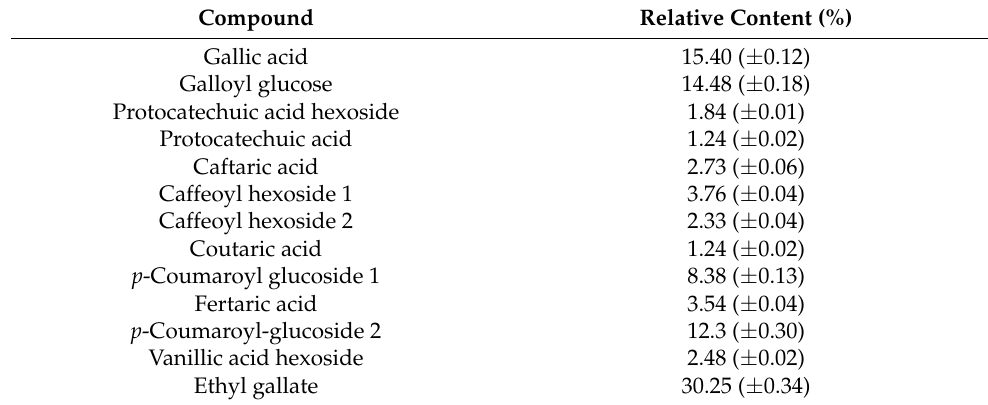
Table 13. Relative content of phenolic acids in the EtOH-H 2 O extract. The % was determined by measuring the peak area of each compound in respect to the sum of the peak areas of all the identified phenolic